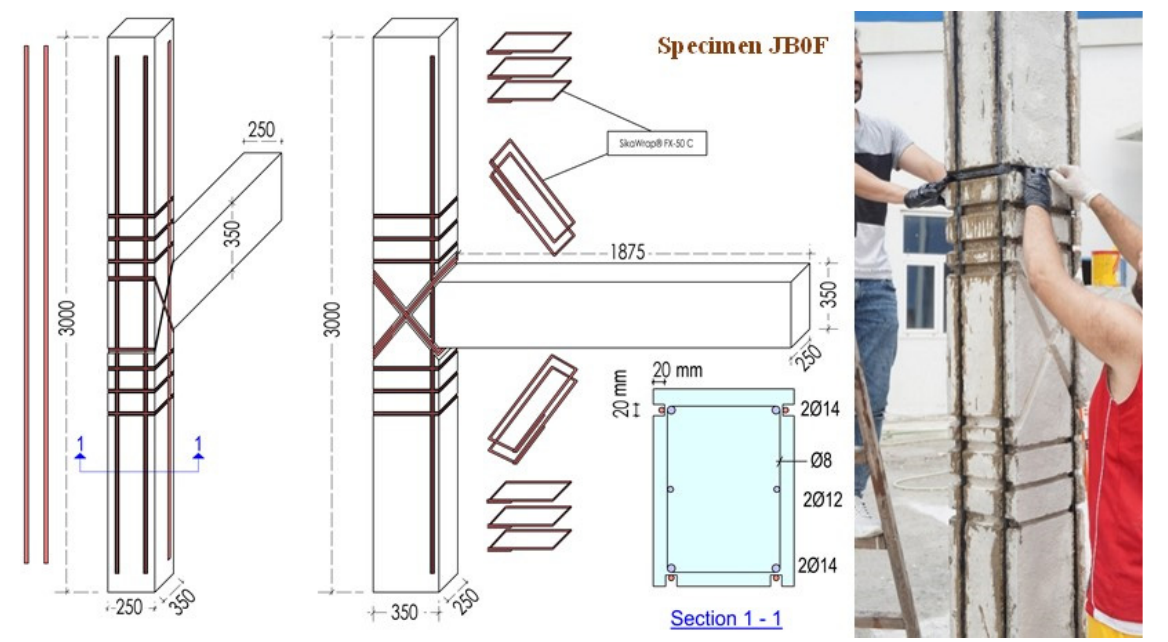
Figure 2. Dimensions and strengthening scheme applied on specimen FB0F. Ropes were added at the four corners of the column along the height, as external longitudinal reinforcement, and, further, ropes were added round the column as external confining stirrups at the critical zones of the column and, finally, diagonally placed C-FRP ropes were mounted on each one of the two sides of the joint as strengthening reinforcement of the joint body.